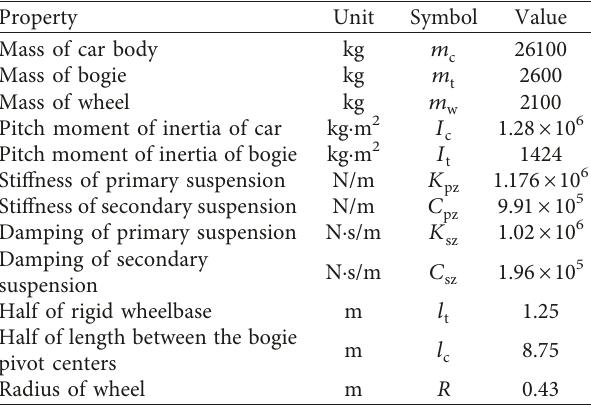
Figure 1: Vehicle and track model: (a) vehicle model; (b) ballastless slab track model. Table 1: Properties for CRH2 EMU trailer.